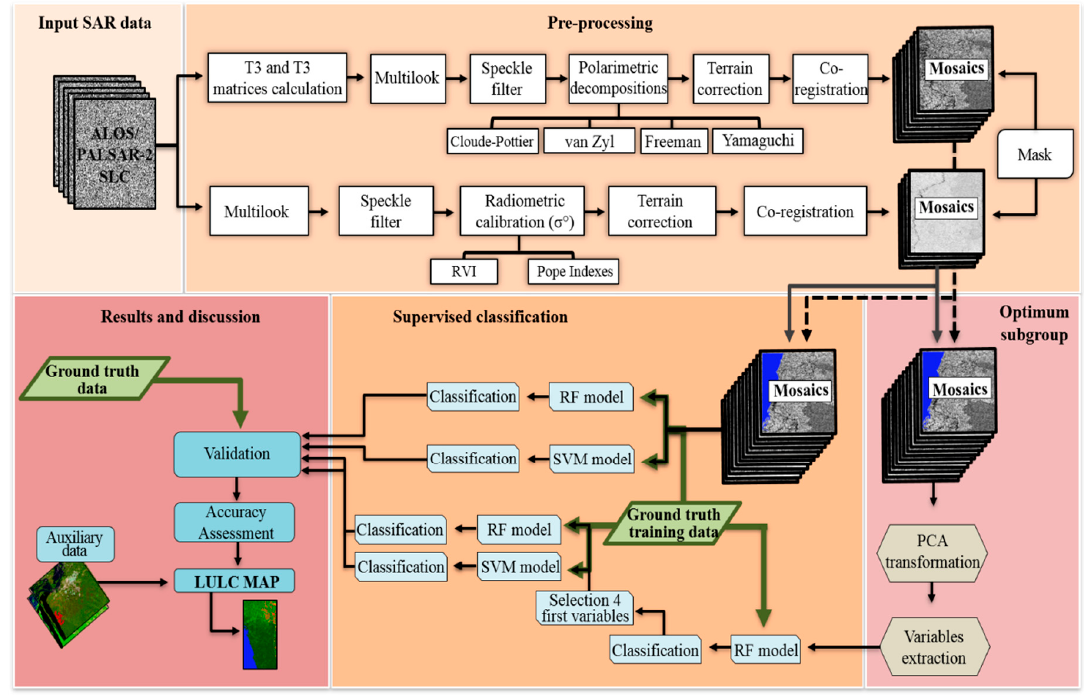
Figure 2. Flowchart of the methodology used to discriminate the land use, land cover, and forest degradation in Tapajós National Forest region, Brazil.